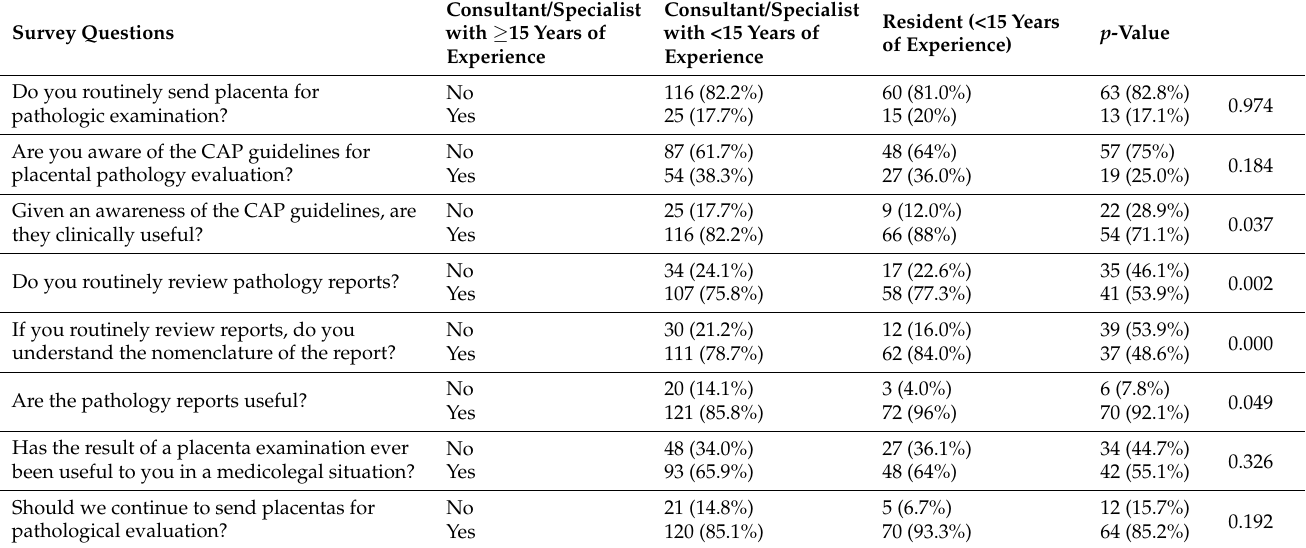
Table 5. Bivariate analysis comparing the responses to the survey questions across the three groups of